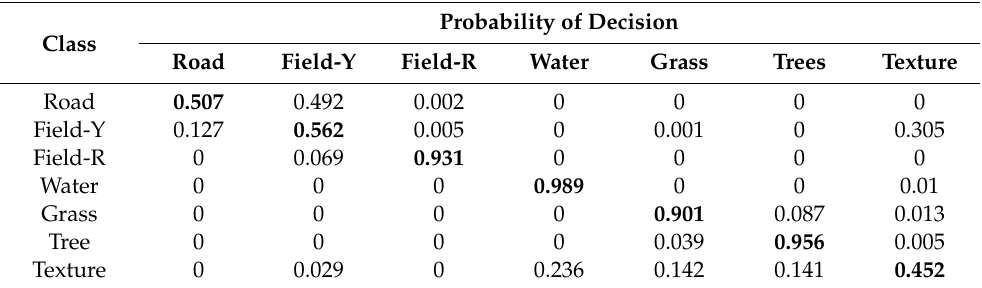
Confusion matrix for compressed image classified by NN trained for this image (PSNR-HVS-M = 36 dB).